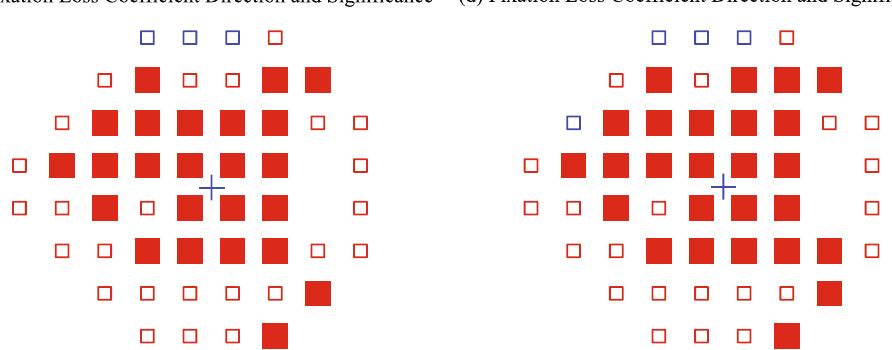
Gaussian Process Regression. To estimate a continuous distribution of NBSL from discrete NBSL measurements at grid locations, Gaussian process regression was used to compute the continuous distribution of the frequency of eyes at each discrete NBSL 34 . Typically Gaussian process regression can give the best linear unbiased prediction for unknown spatial locations. Herein we briefly describe the concept of Gaussian process regression. Details can be found in the literature 35 . → For a Gaussian process, each entry of the n observations y = { y 1 , … , y n } in spatial domain Ω x ( ) is associated with a normally distributed random variable, and a finite collection of those random variables has a multivariate normal distribution. Thus, the expected value of the unobserved variable y at spatial location can be interpolated * by maximizing the probability of y conditioning on known n observations y assuming [ y , y ] to be a multivariate * * normal distribution. Gaussian process regression relies on a covariance function that represents the spatial rela- tionship between the samples. Here, we apply a frequently chosen covariance function